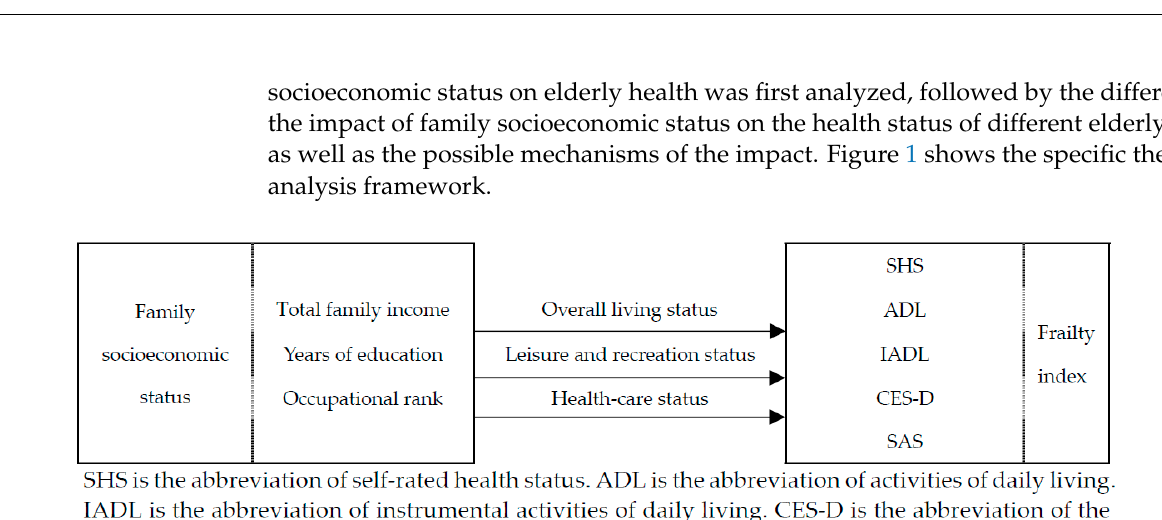
Figure 1. Framework diagram of theoretical analysis.